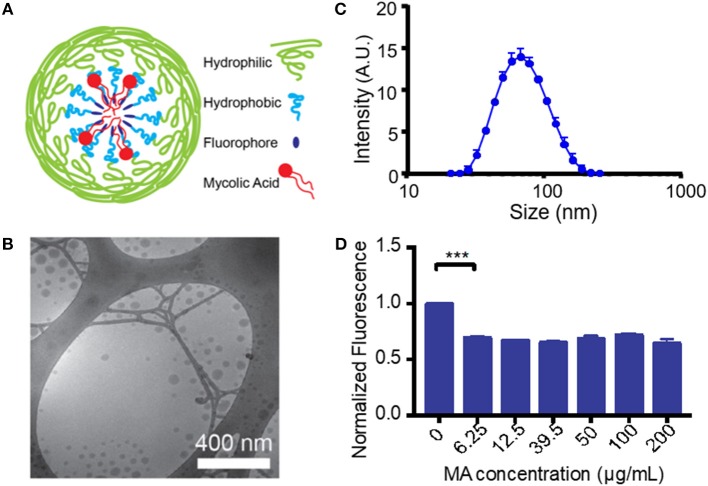
Generation and characterization of mycolic acid-loaded micelles. (A) The structure of mycolic acid (MA) loaded PEG-PPS-ASF micelles (MA-ASMc) is represented as a cartoon. Load of MA results in protonation of the fluorophore to decrease fluorescence. (B) Representative images of MA-ASMc nanocarriers visualized by cryogenic transmission electron microscopy. (C) Dynamic light scattering measurements of MA-ASMc hydrodynamic diameter. Error bars represent standard deviation (SD), n = 6. (D) Micelles were made with different loadings of MA and fluorescence was measured. Micelles at all concentration of MA > 6.25 μg MA/10 mg PEG-PPS-ASF (1:558 molar ratio) showed a 30% decrease in fluorescence. ***P < 0.001.